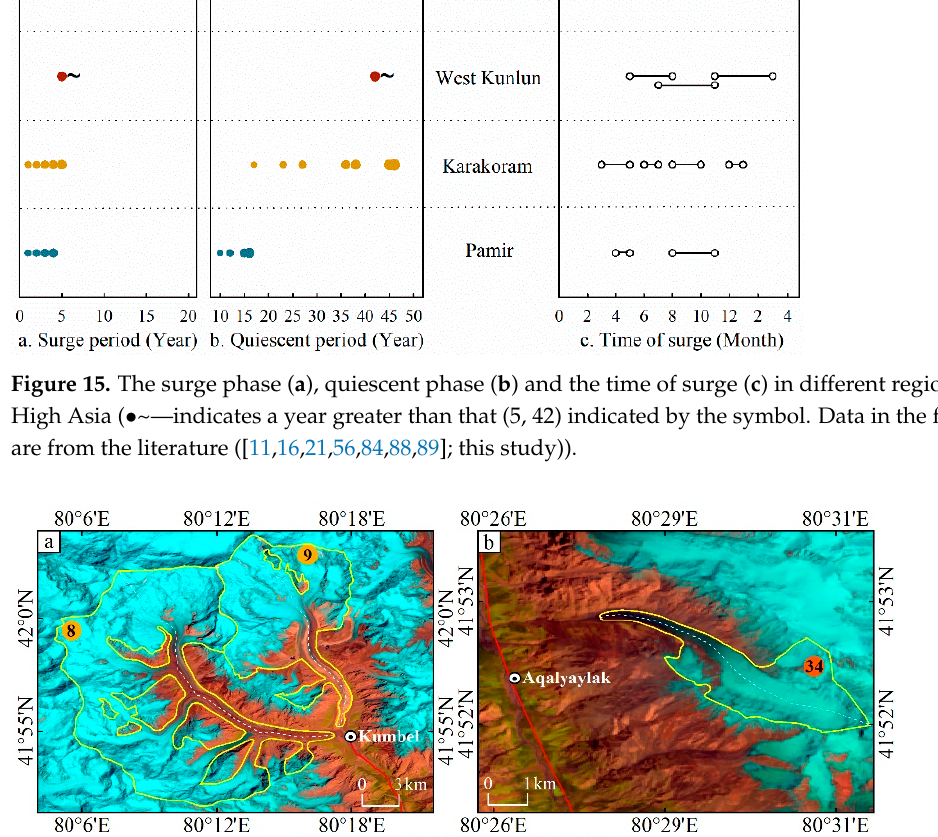
Figure 16. Hazard assessment for two advancing and surging glaciers near the villages of ( a ) Kumbel and ( b ) Aqalyaylak in the Tien Shan region.